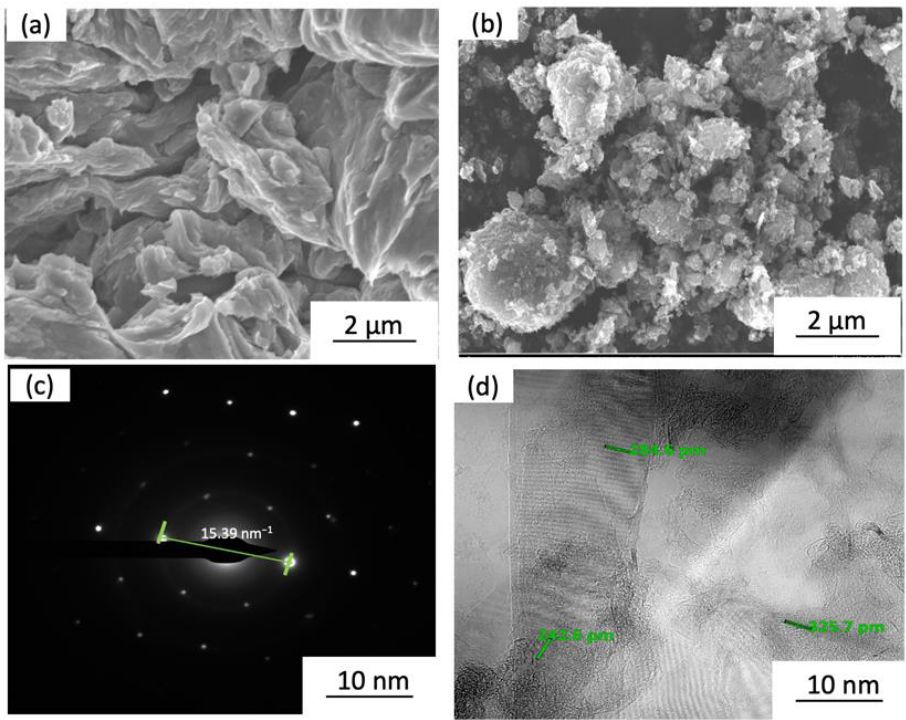
Figure 4. FE – SEM images of ( a ) Al alloy A356, ( b ) Graphene nanoplatelets (GNP S ), and ( c ) SAED pattern of GNPs; ( d ) TEM images of as-received GNPs.